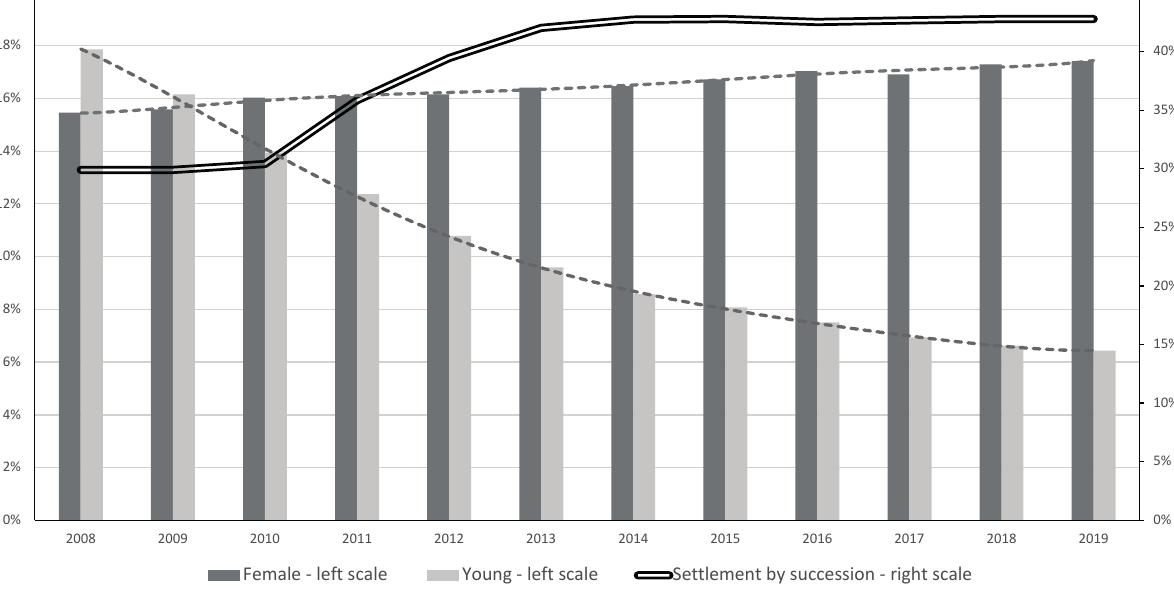
Figure 7. Evolution of the presence of the female, young and organic farmers over the 2008-2019 period within the Italian FADN balanced